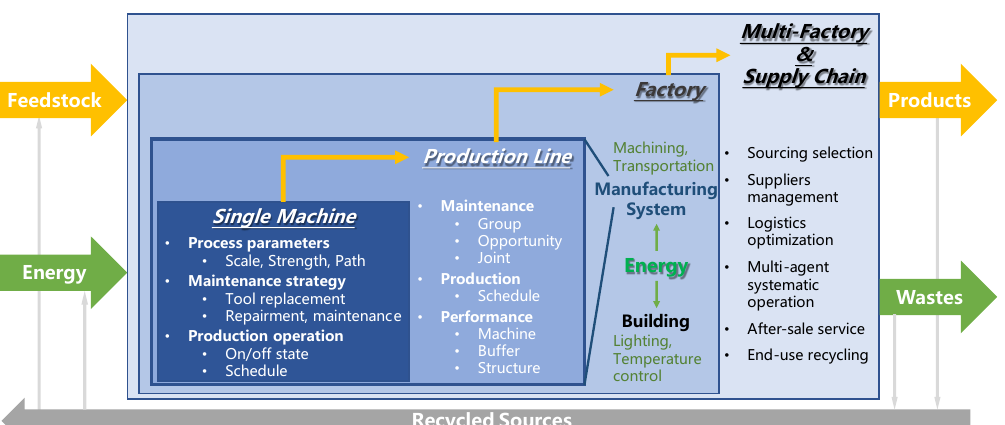
Figure 1. Decision levels of O&M in a manufacturing process.